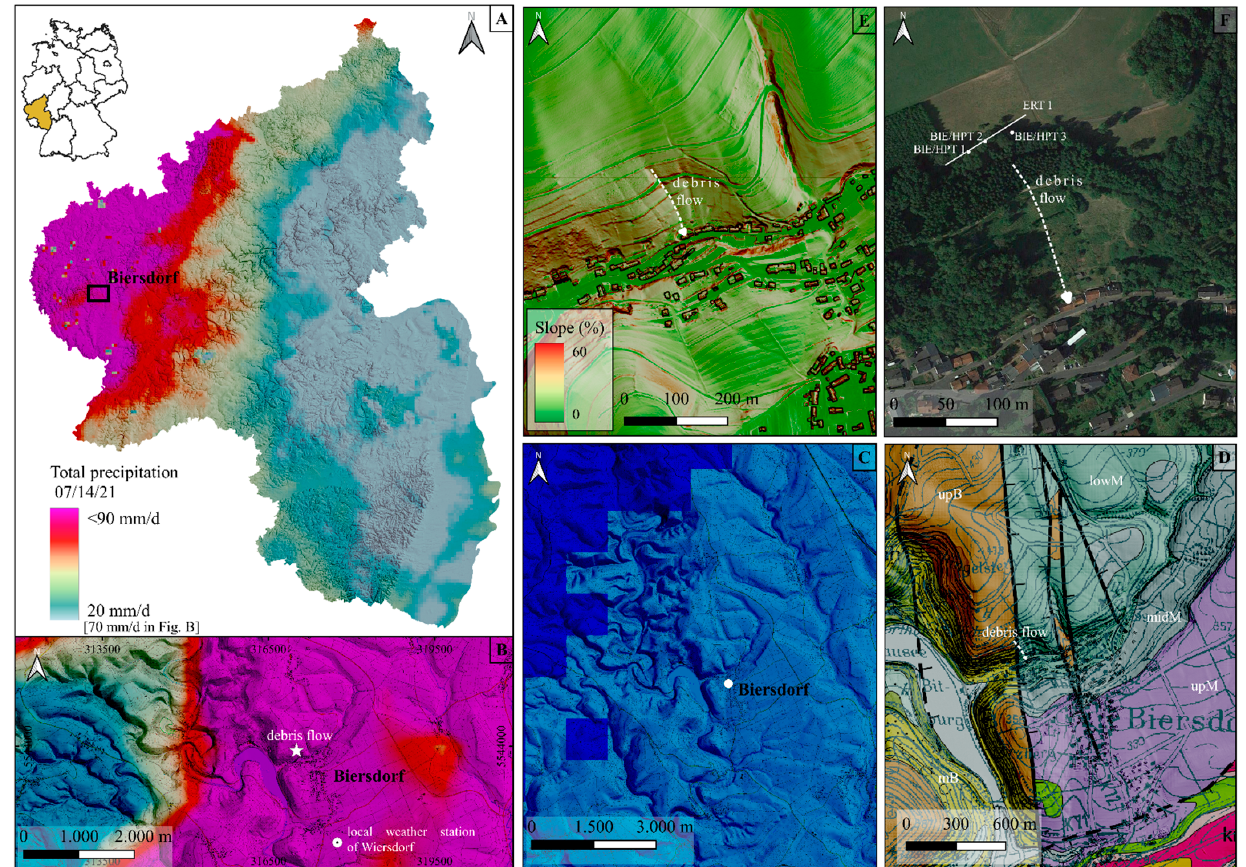
Figure 2. ( A ) Precipitation distribution in Rheinland-Pfalz from 14 July 2021. Derived from the RADOLAN weather data of the DWD [23]. ( B ) Section of the precipitation distribution around Biersdorf with the unit of measurement changed for visualization. ( C ) DWD soil saturation model around Biersdorf from 13 July 2021 with the following units: dark blue = oversaturated ( ≥ 100% usable field capacity), blue = saturated, at the beginning of oversaturation (80 to <100%; DWD 2022, [24]). ( D ) Geological structure and lithologic distribution in the study area (upB = Upper Buntsandstein, lowM = Lower Muschelkalk, midM = Middle Muschelkalk, upM = Upper Muschelkalk). ( E ) Slope of the study area including downhill track of the debris flow. ( F ) Aerial view of the study area with the realized geomorphological prospects